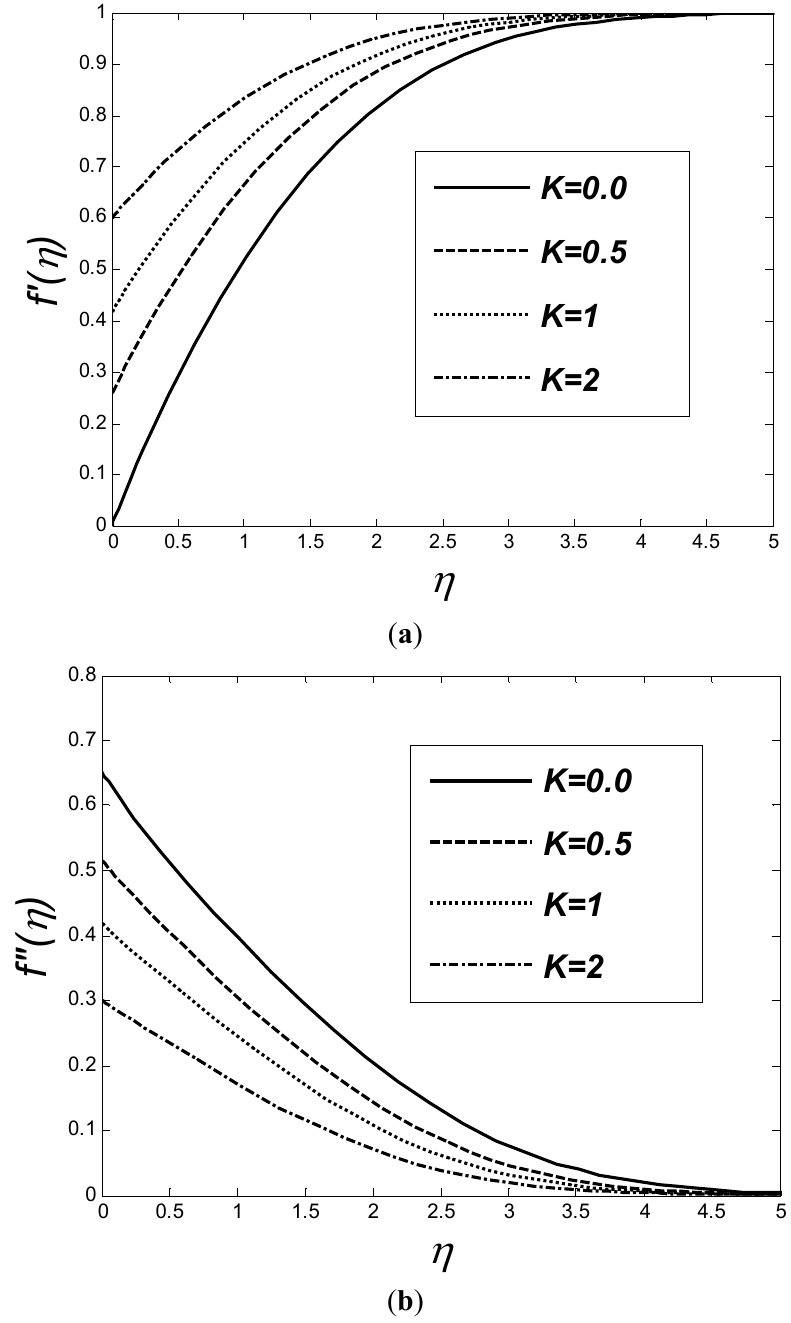
Figure 3. Distribution velocity ( a ) and velocity gradient ( b ) as a function of η for various values of K when M = 0.5, f = w